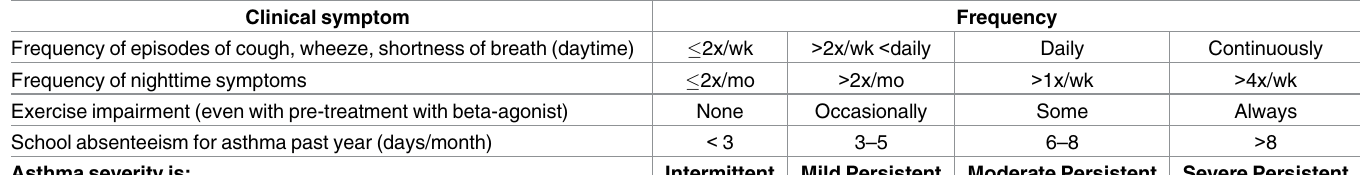
Table 1. Provider Assessment from Easy Breathing Survey used by Clinicians to Determine Asthma